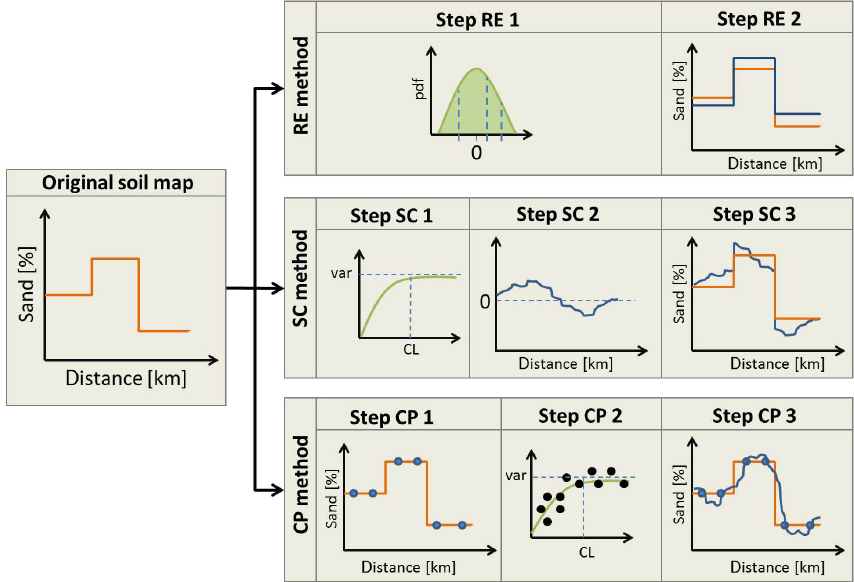
Figure 1. Soil perturbation methods (random error method, RE; spatially correlated method, SC; and conditional points method, CP). The panel on the left shows the percentage of sand of a hypothetical horizontal transect trough the original soil map as an orange line. Within the transect three different soil units are observed, which leads to three different sand contents. Each row of the right panels depicts the steps for setting the perturbation methods. The blue line depicts one realization of the respective perturbation method. The detailed description of these methods can be found in Sect. 2.1. Abbreviations: var – variance, CL – correlation